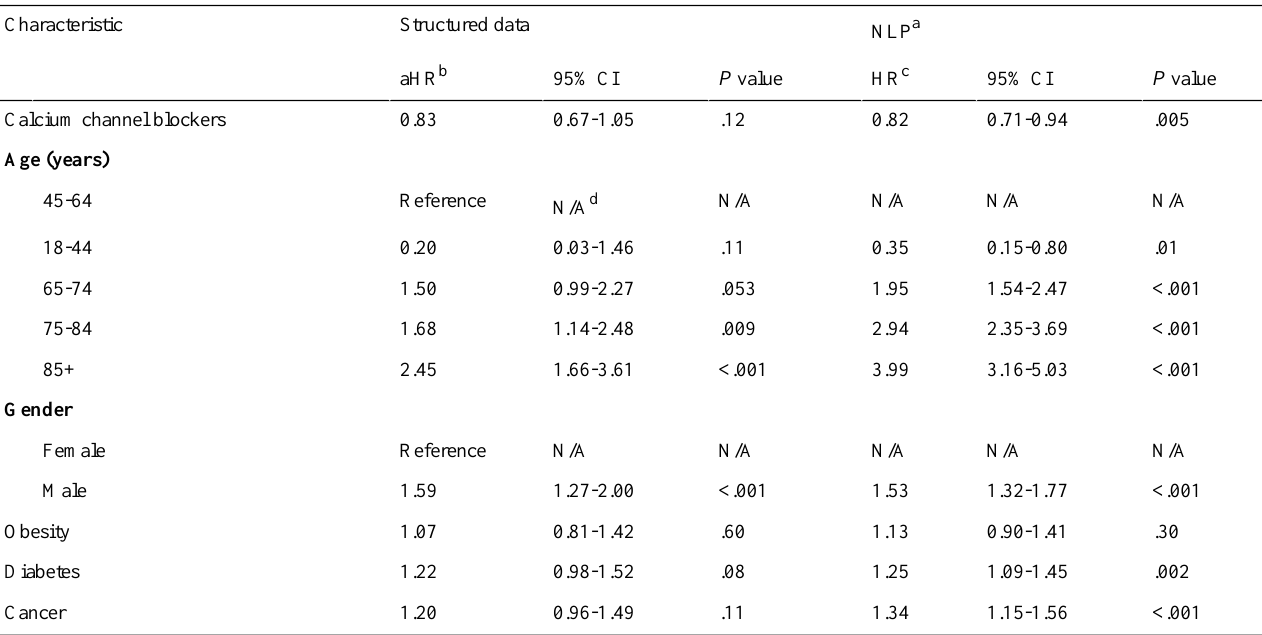
Table 2. Results of the multivariate Cox survival